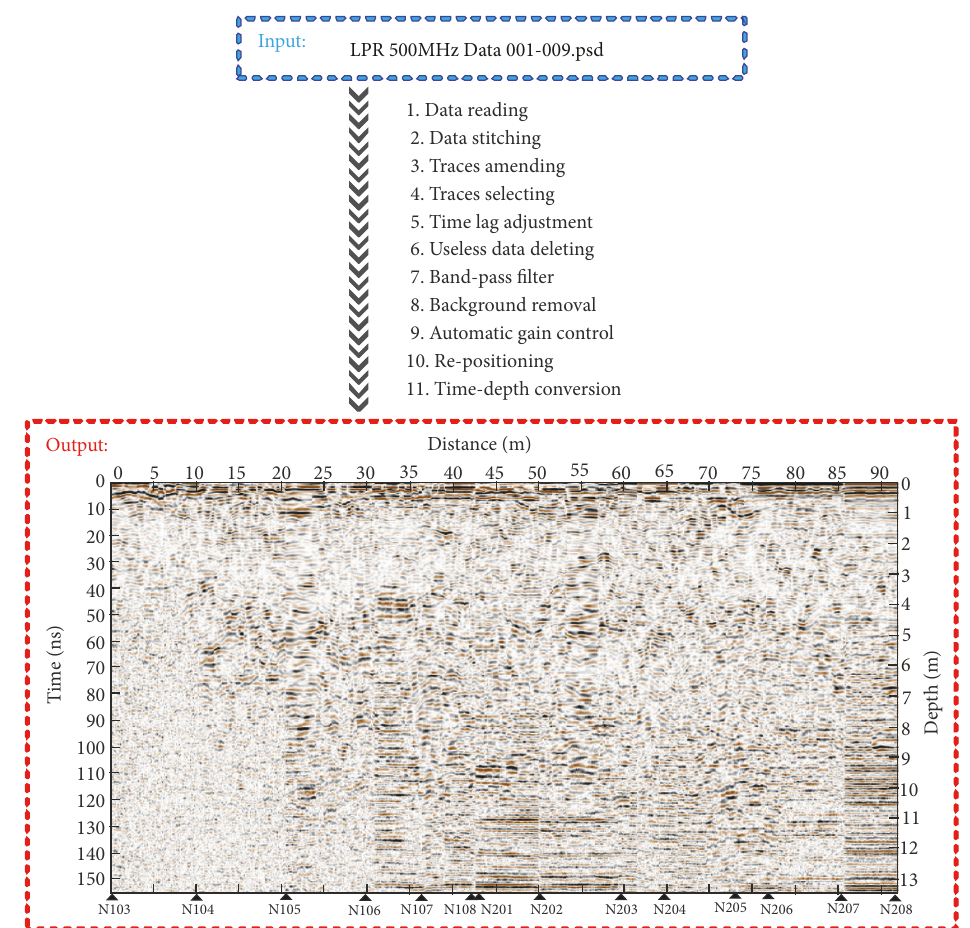
Figure 2: A workflow chartof CH-2 LPR data processing. The relative dielectric constant is set to be 3. N103-N209denote the positions where the LPR was